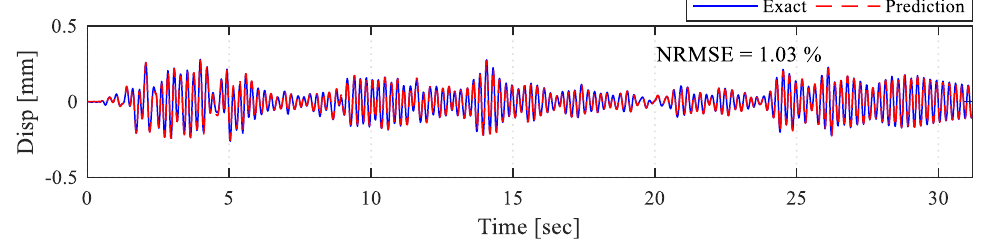
Figure 15. LSTM-predicted brace displacement input from Model 1b RTHS test with specimen but based on actual feedback as compared to the exact analytical solution.